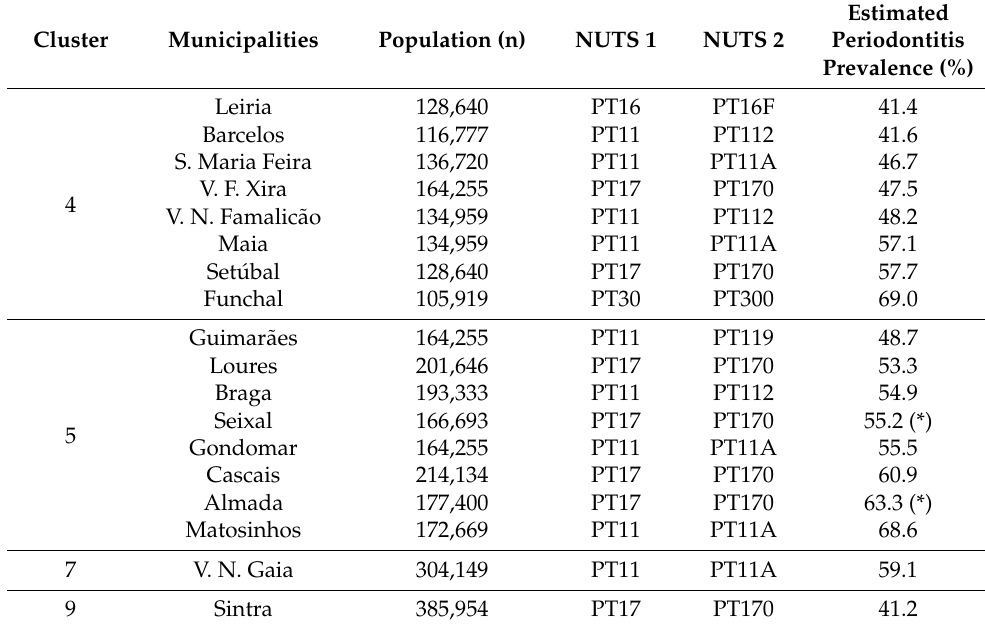
Cluster Municipalities